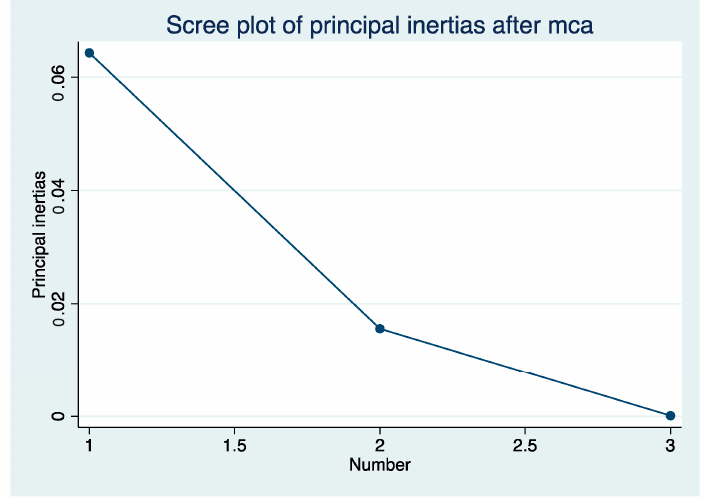
Figure 2. Scree plot of principal inertias obtained from MCA. Source: Authors’ calculations.